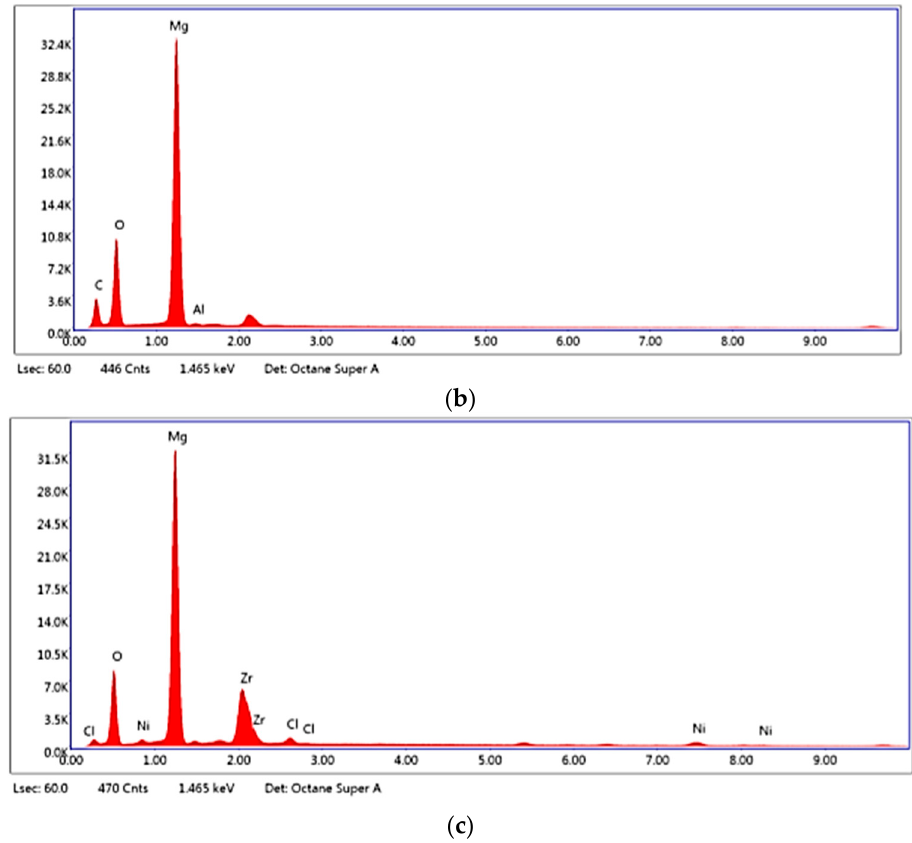
Figure 8. The energy dispersive X-ray spectrocopy (EDX) of ( a ) Zr (x )Ni (y) nanocatalyst; ( b ) milled-MgH 2 as reference; ( c ) MgH 2 /10 wt.% Zr (x) Ni (y) nanocomposite.